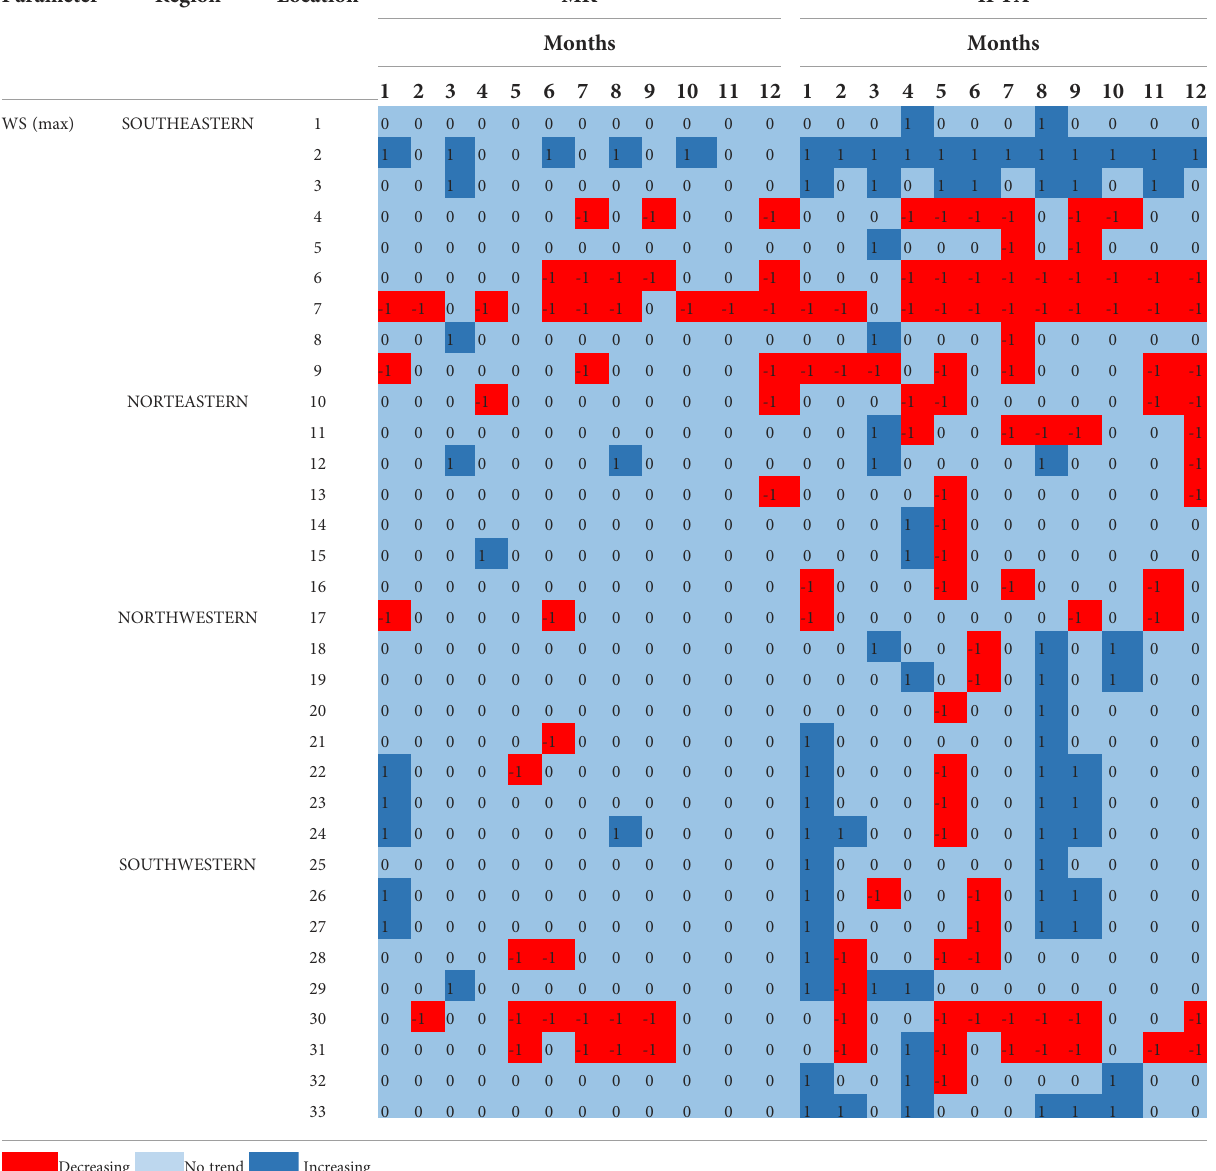
TABLE 4 Comparison of trend test results from different methods for maximum WS. Parameter